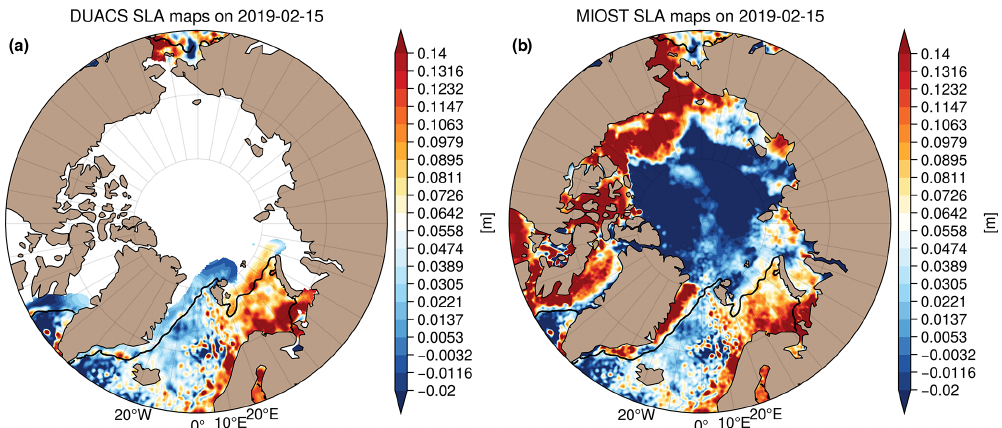
Figure 5. Example of sea-level anomaly maps on 15 February 2019 over the Arctic region constructed with the DUACS mapping approach (a) and with the MIOST mapping approach (b) . The black line contour indicates the 15% sea-ice concentration from the OSI-SAF product.